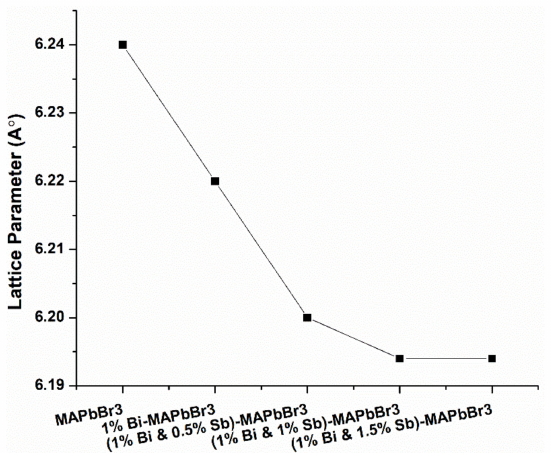
Figure 3. Lattice constants of pure MAPbBr3 and co-doped (1%Bi and 0.5%, 1% and 1.5%